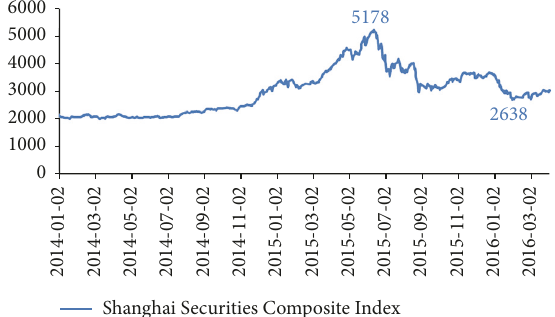
Figure 1: Trend of Shanghai Composite